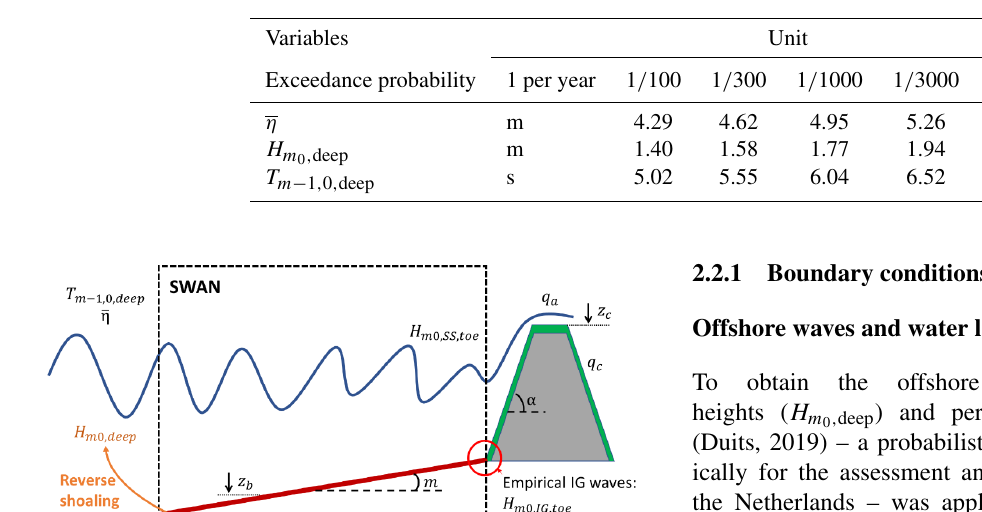
Table 1. Characteristic values for offshore waves and water levels at the Uithuizerwad field site.